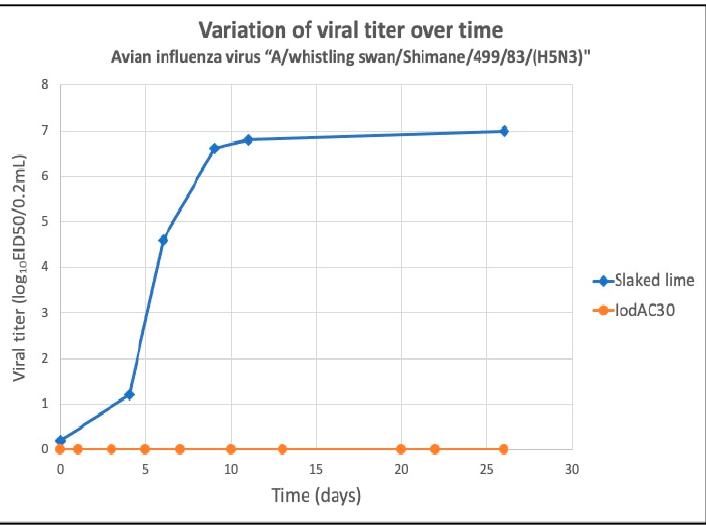
Figure 12. IodAC vs. slaked lime: variation of antiviral effectiveness.